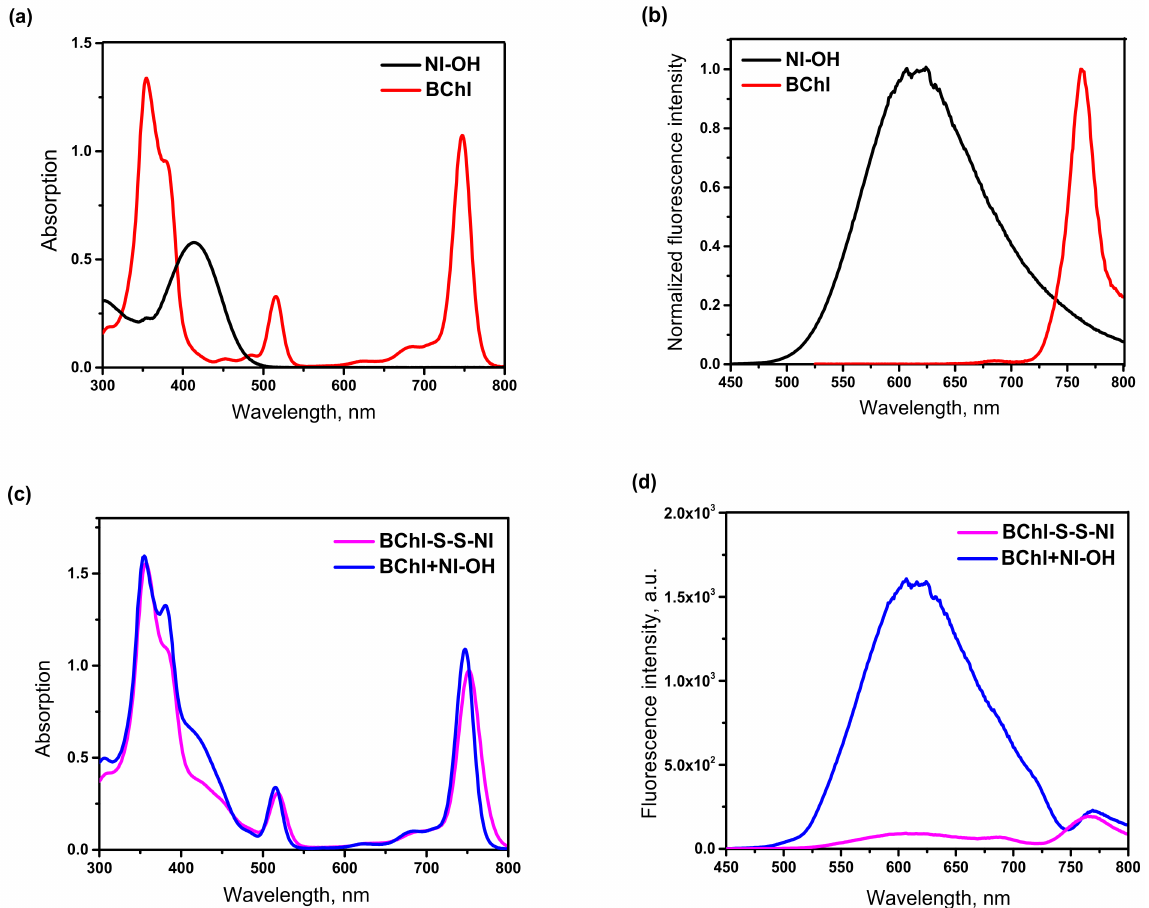
Figure 3. UV/Vis absorption ( a , c ) and fluorescence emission ( b , d ) spectra of compounds BChl,